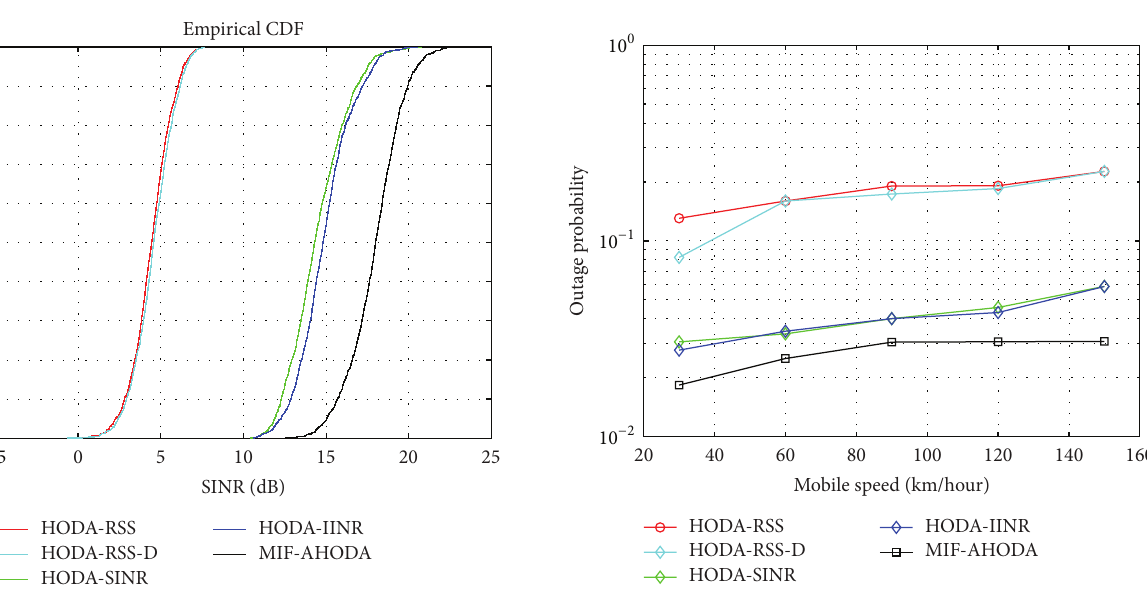
Figure 5: Average user’s serving SINR over the PCC.